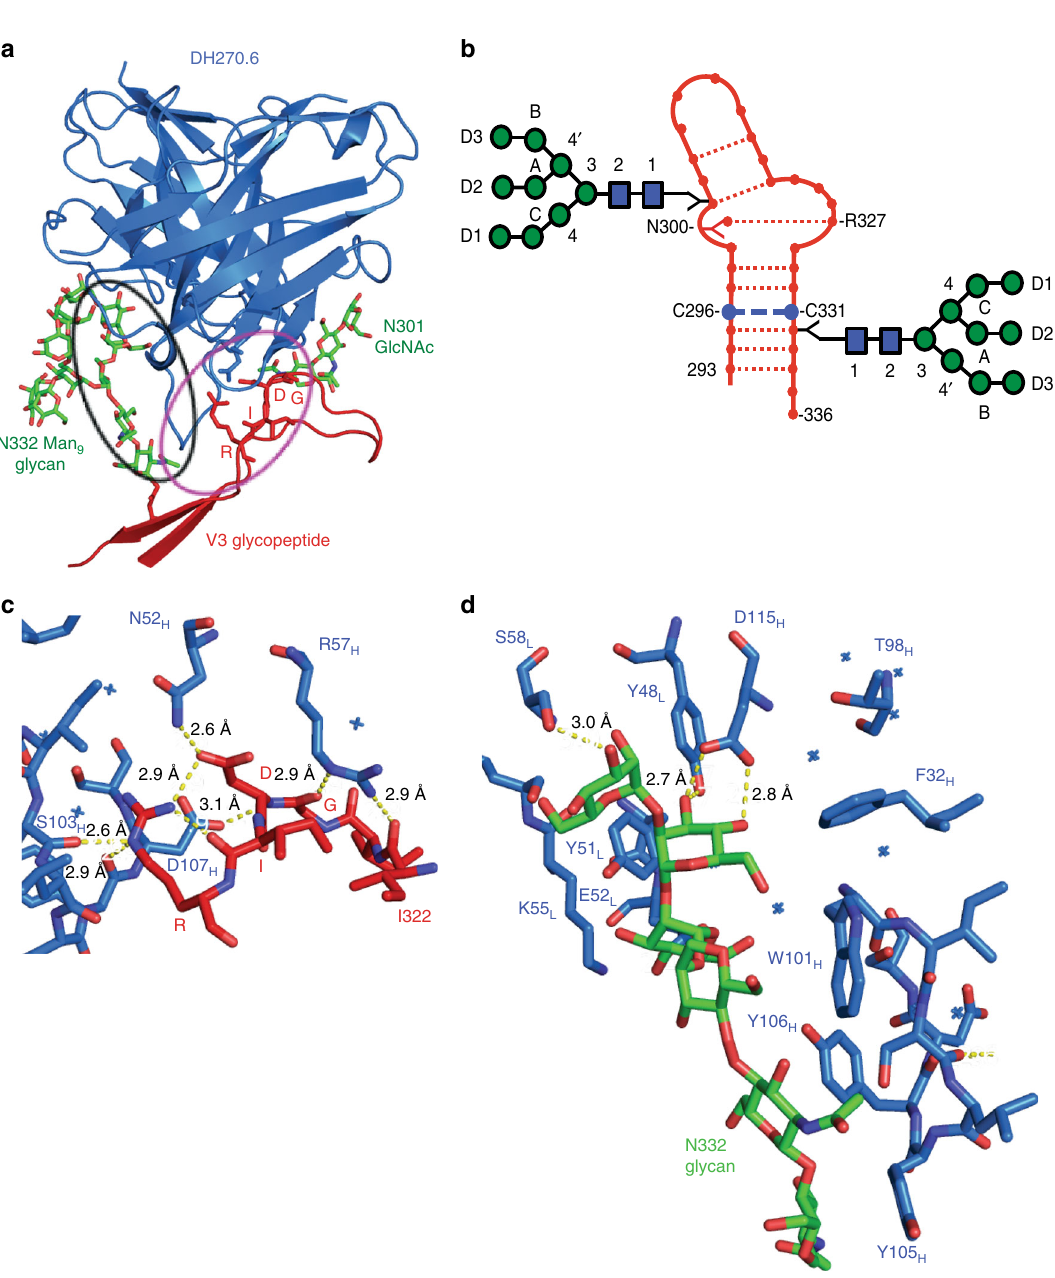
Fig. 2 DH270.6-Env V3 loop structure. a DH270.6-Man 9 -V3 crystal structure. The V3 region of the 324 GDIR 327 motif is labeled, and glycans are shown as green sticks. The two major anchor points are circled. b Secondary structure of Man 9 -V3. Each node (.) represents a peptide backbone carbonyl or amide group; dashed lines represent hydrogen bonds; Y represents a side chain; Man 9 glycans are shown as colored forks. A schematic diagram of the Man 9 GlcNAc 2 glycan with the glycan moiety nomenclature is also shown. c The antibody- 324 GDIR 327 motif hydrogen bonds. d Contacts between the antibody and Man 9 D1